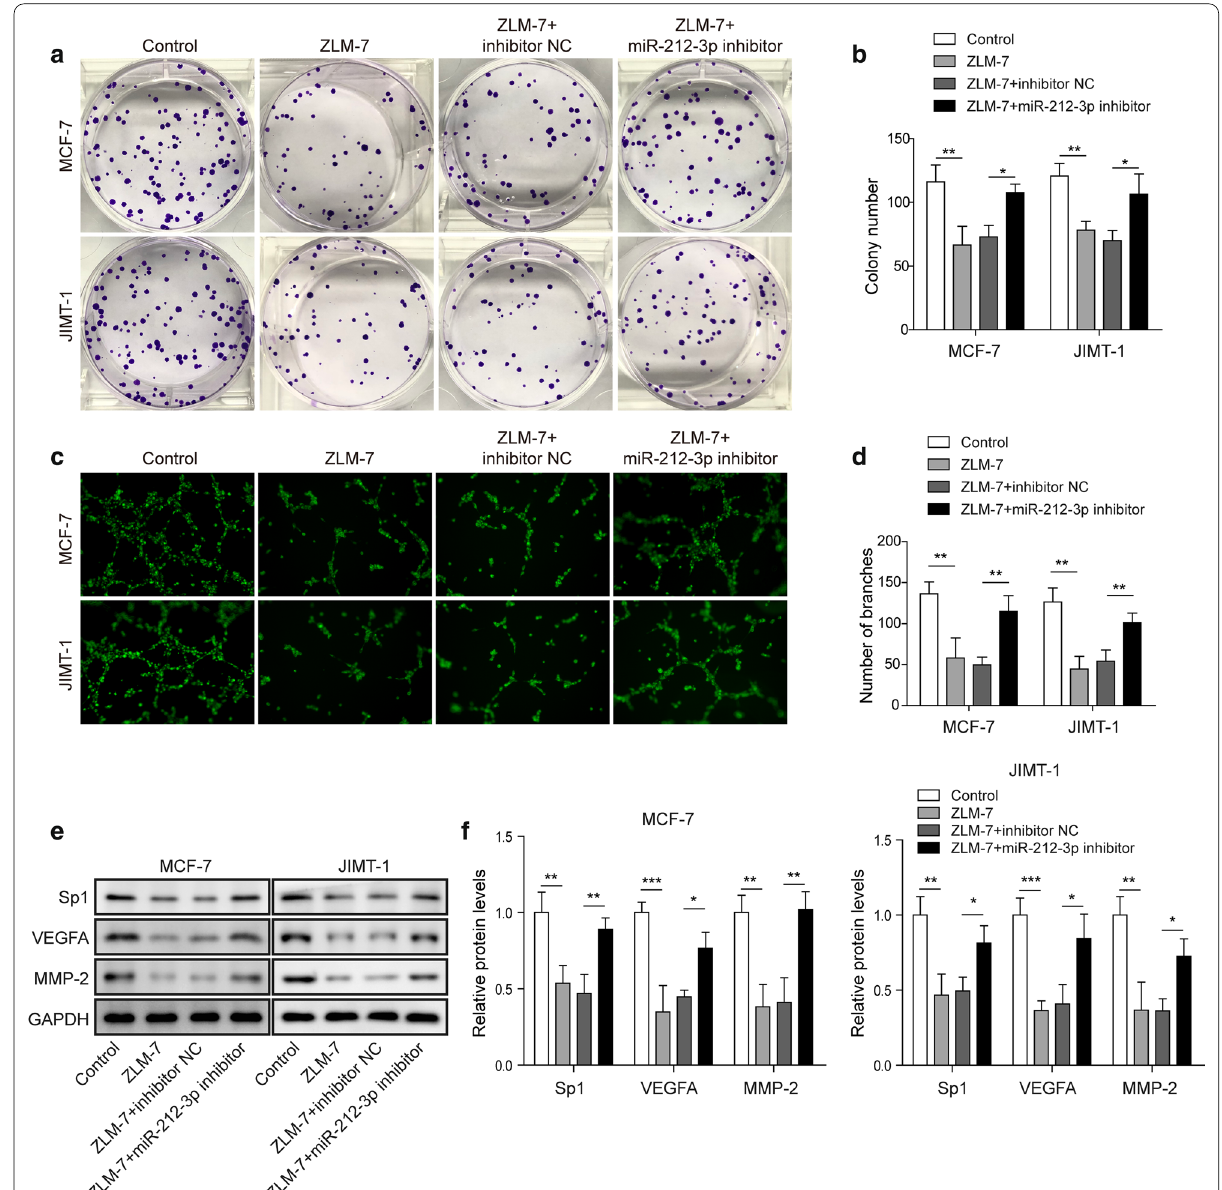
Fig. 2 ZLM‑7 inhibited the proliferation and angiogenesis of BC cells by up regulating the expression of miR‑212‑3p. a , b Cell proliferation of MCF‑7 and JIMT‑1 was determined by colony formation in cells treated with ZLM‑7 and miR‑212‑3p inhibitor. c , d Tube formation analysis in MCF‑7 and JIMT‑1 treated with ZLM‑7 and miR‑212‑3p inhibitor. e , f Western blot analysis in of MCF‑7 and JIMT‑1 cells treated with ZLM‑7 and miR‑212‑3p inhibitor. Relative intensity of bands of each protein were normalized to loading control GAPDH. * P < 0.05, ** P < 0.01, *** P <